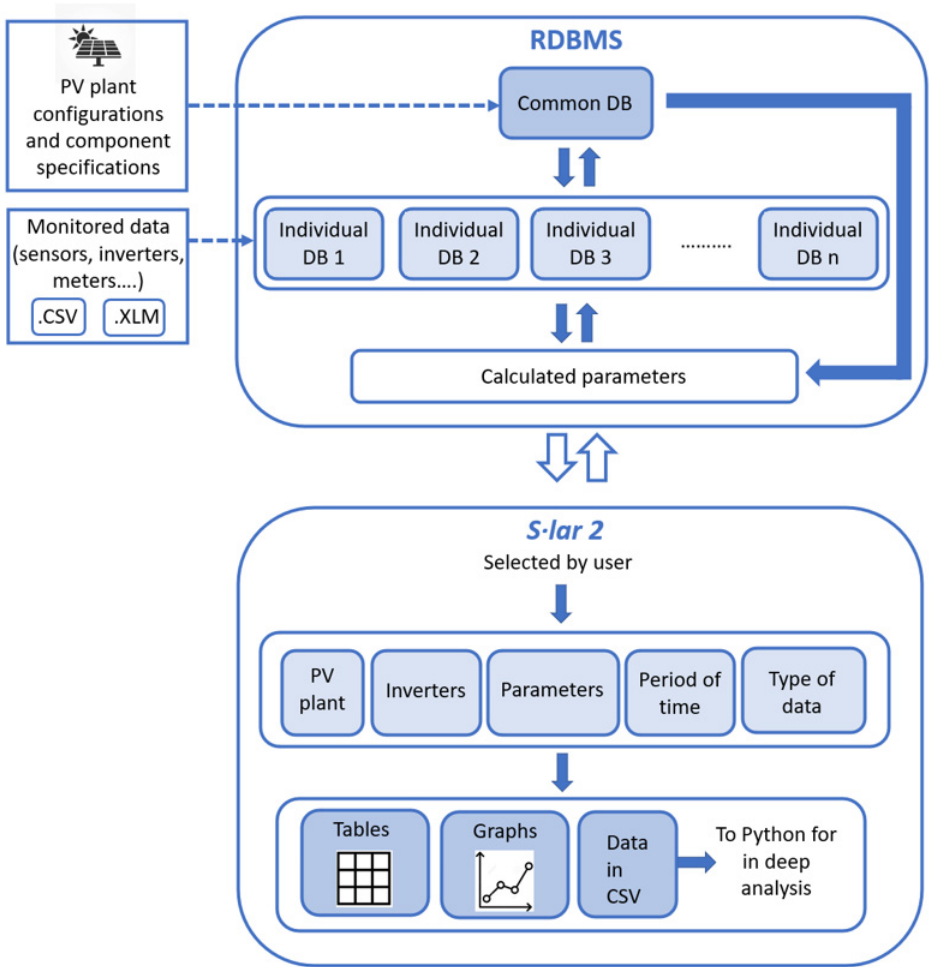
Figure 5. Schematic diagram representing the structure of the developed system for data analysis from PV plants.